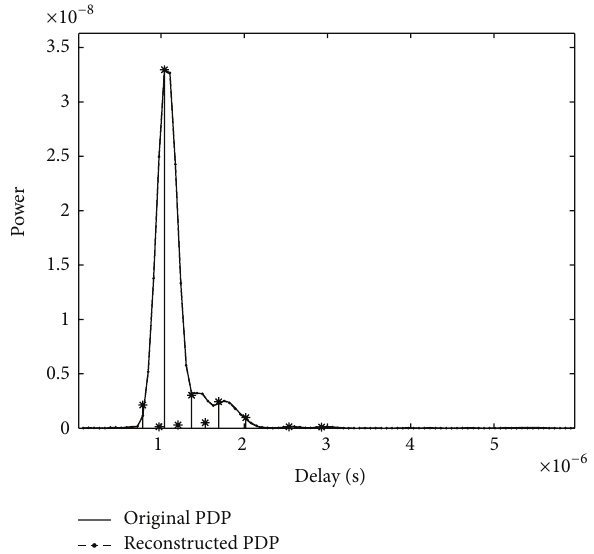
Figure3:AnexampleofanoriginalchannelPDPandthePDPofthe channel reconstructed based on the multipath parameter estimates. The powers of the estimated paths versus the path delays are also illustrated.